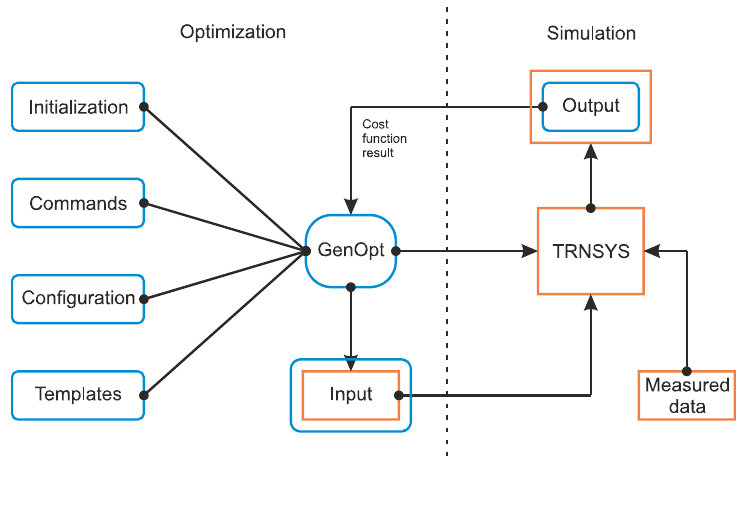
Figure 8. The linking scheme for GenOpt and